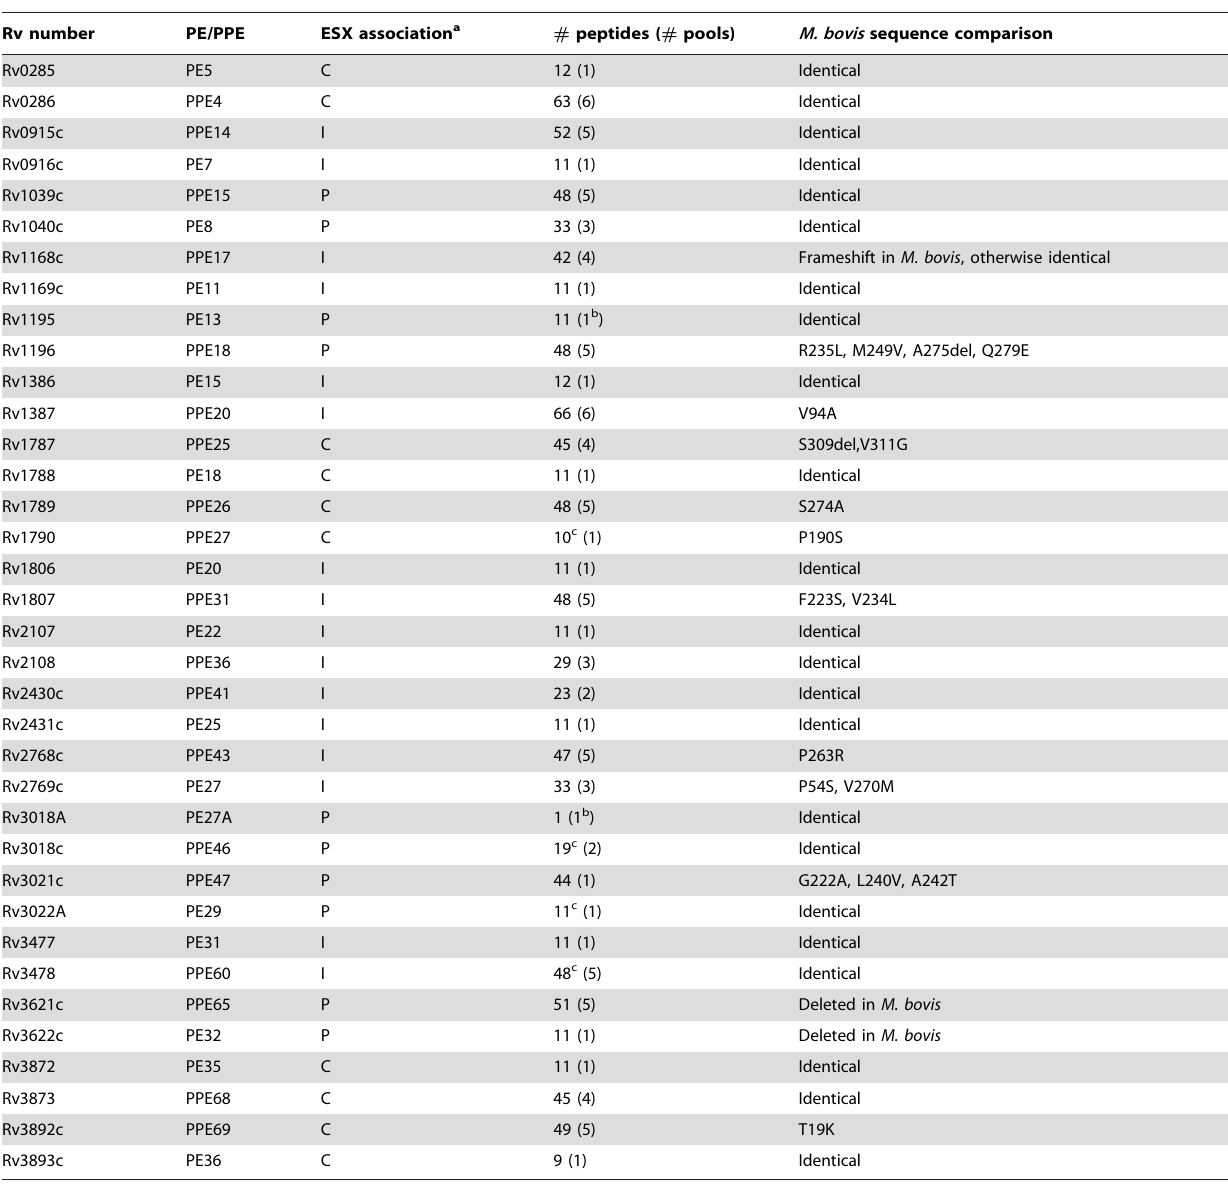
Table 1. PE/PPE proteins selected for this